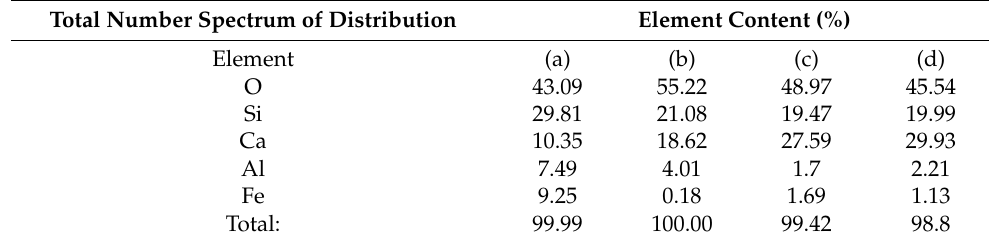
Table 4. Main elements of the hydration product